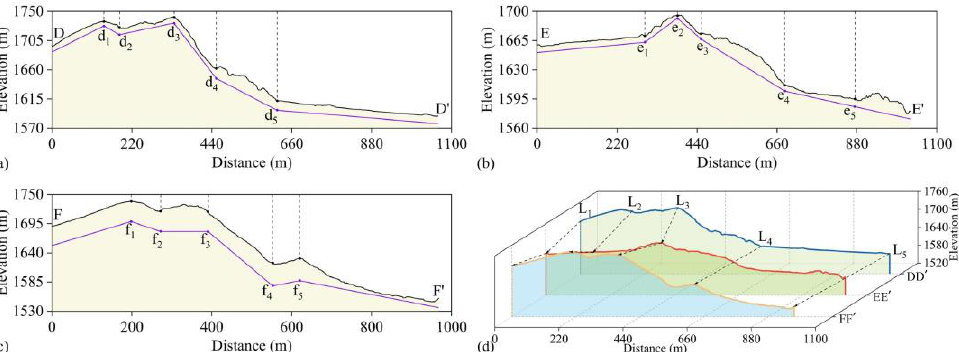
Figure 9. Results of the transverse section lines’ elevation analysis, ( a ) the elevation change of the transverse section line 𝐷𝐷′ , ( b ) the elevation change of the transverse section line 𝐸𝐸′ , ( c ) the elevation change of the transverse section line 𝐹𝐹′ , and ( d ) the elevation change trend of the three transverse section lines.